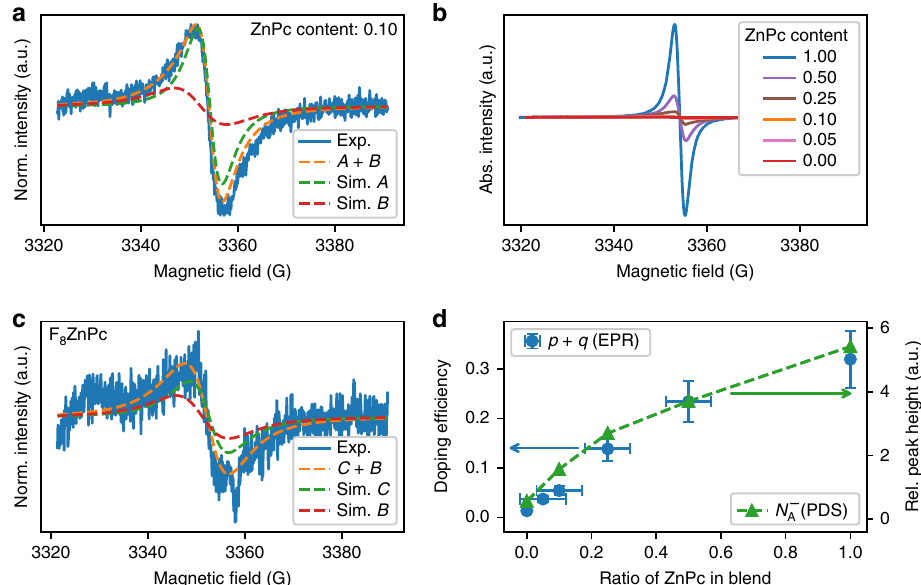
Fig. 2 EPR spectra and analysis of p-doped fi lms. Continuous wave EPR measurements, in the dark and at room temperature, on blends p-doped with 0.05 MR of F 6 -TCNNQ. a EPR spectra of ZnPc:F 8 ZnPc at weight ratio of 0.10:0.90. The dashed orange lines represent the spectral simulations of the EPR spectrum obtained as the sum of two contributions from the ZnPc positive polaron (species A, green dashed line) and the F dashed line). b EPR spectra of all the blend ratios. c EPR spectra of F 8 ZnPc. The positive polaron is marked as species C as it has a larger g -value. d Doping ef fi ciency ð p þ q Þ = N (blue circles, left axis), as calculated from the EPR signal, plotted against weight ratio of ZnPc in the blend. The relative peak intensity A N (cid:2) from the PDS measurements are also plotted (right axis, green triangles). The error bars are propagated from the uncertainty in the spectral simulations A and material deposition 1.77 eV (701 nm) and are plotted in Fig. 1b against the ratio of